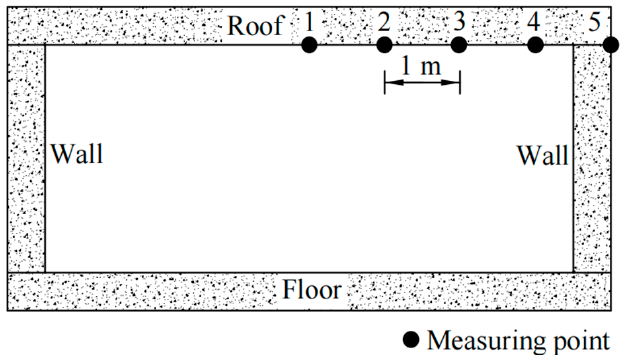
Figure 12. Schematic diagram of numerical simulation measuring point distribution.